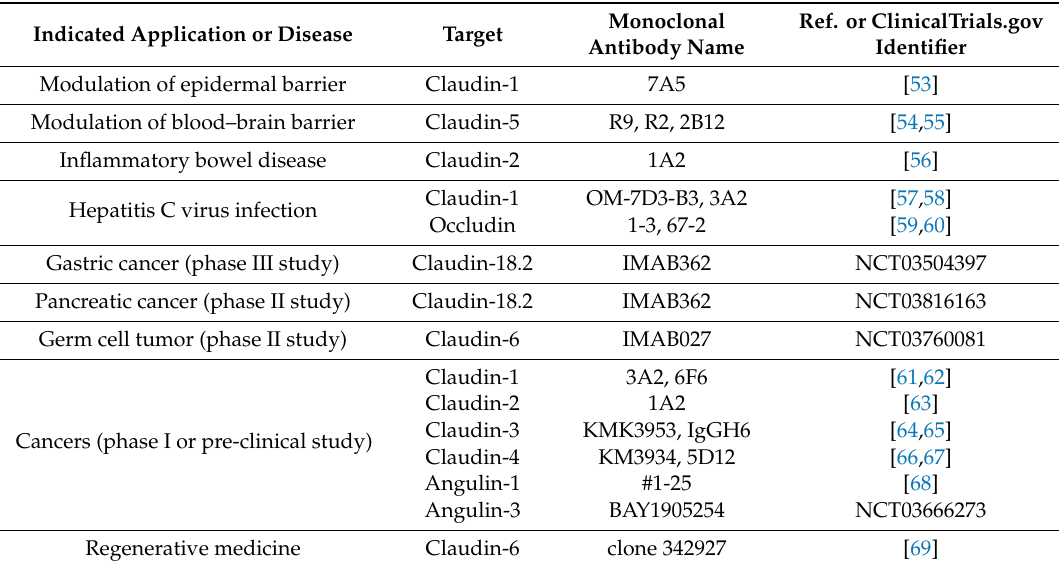
Table 2. List of current monoclonal antibodies against tight junction components. Indicated Application or